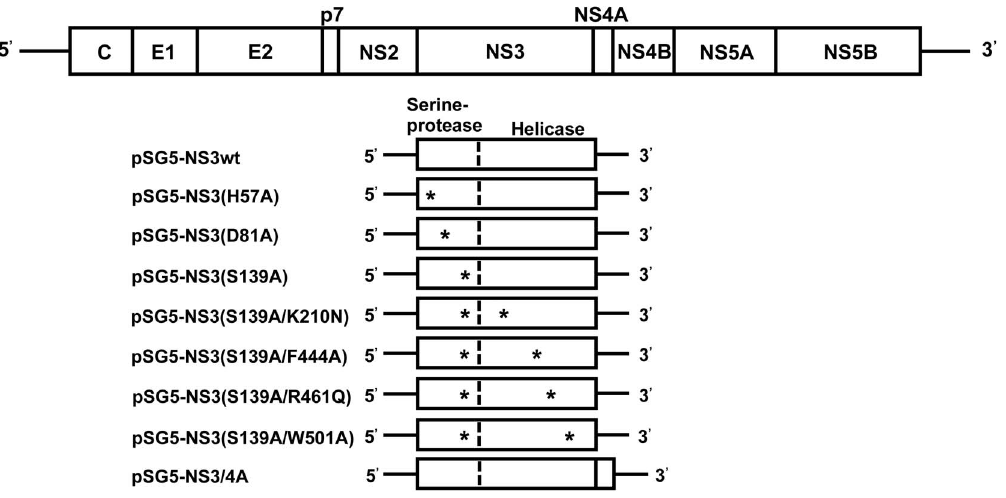
Figure 1. Schematic representation of the HCV genome and the NS3 region with various point mutations. The HCV genome (top) as well as NS3wt and various NS3 mutants are shown. Asterisks indicate point mutations in the serine protease and NTPase/RNA helicase domains.